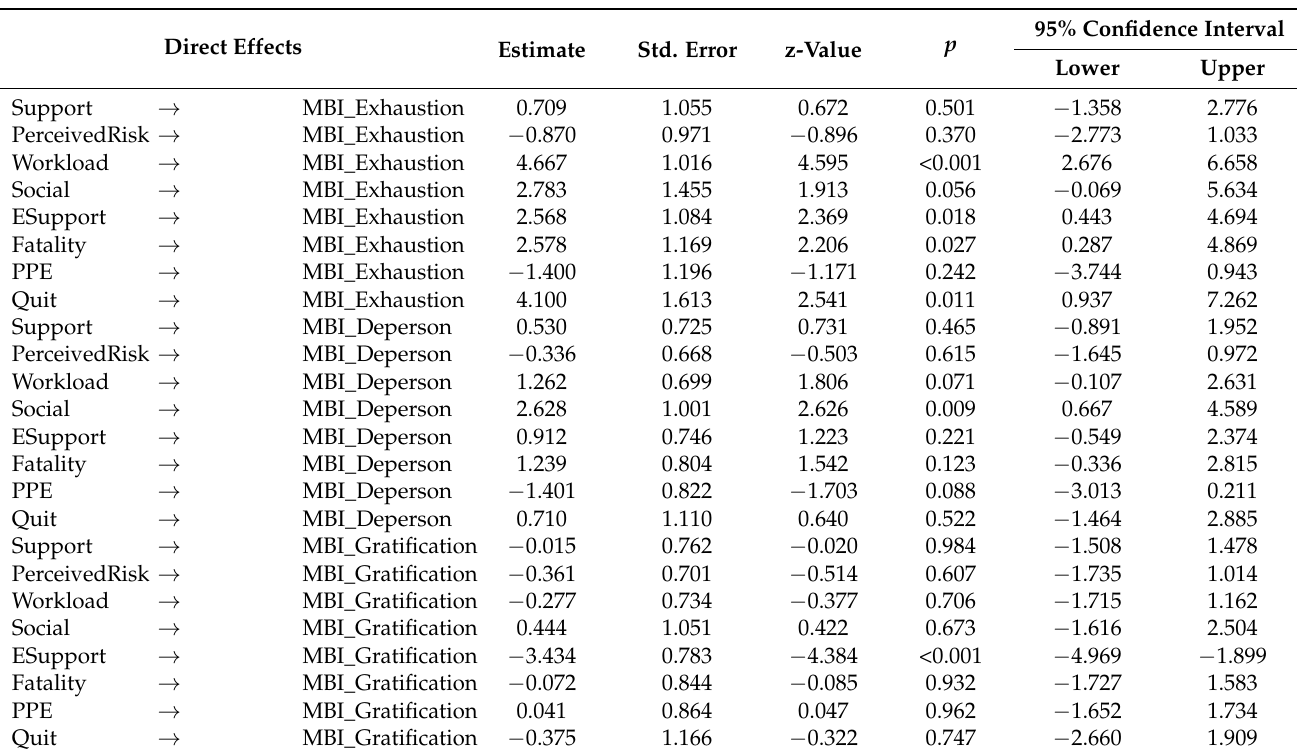
Table 7. Mediation analysis on the direct relationship between working factors and MBI domains of burnout.